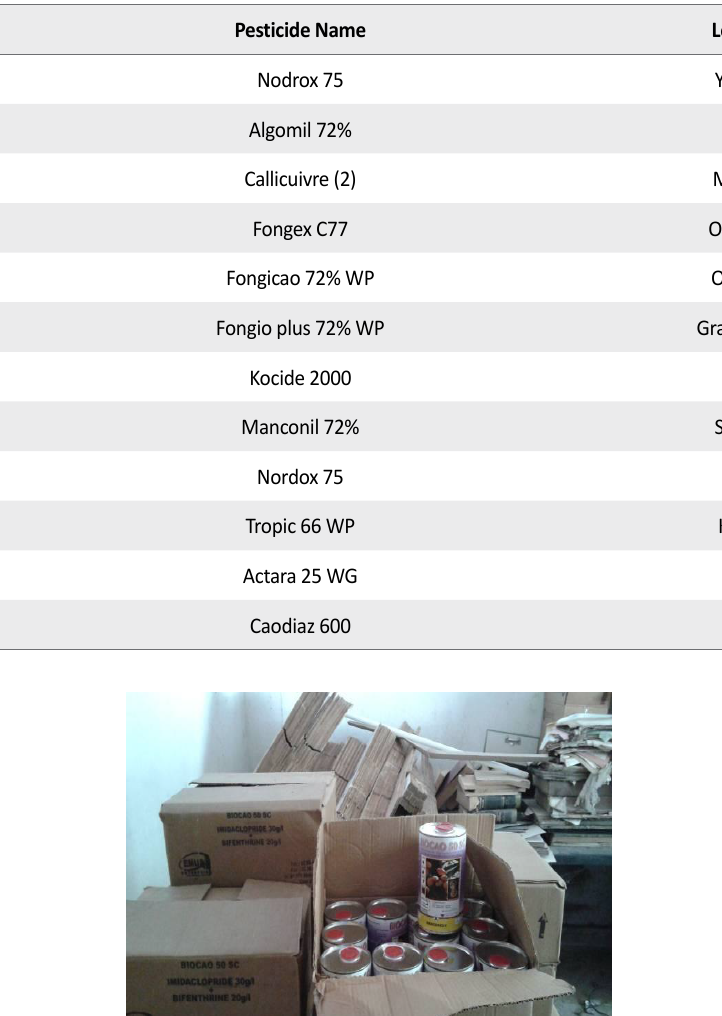
Table 1. Pesticides used in Soubré department